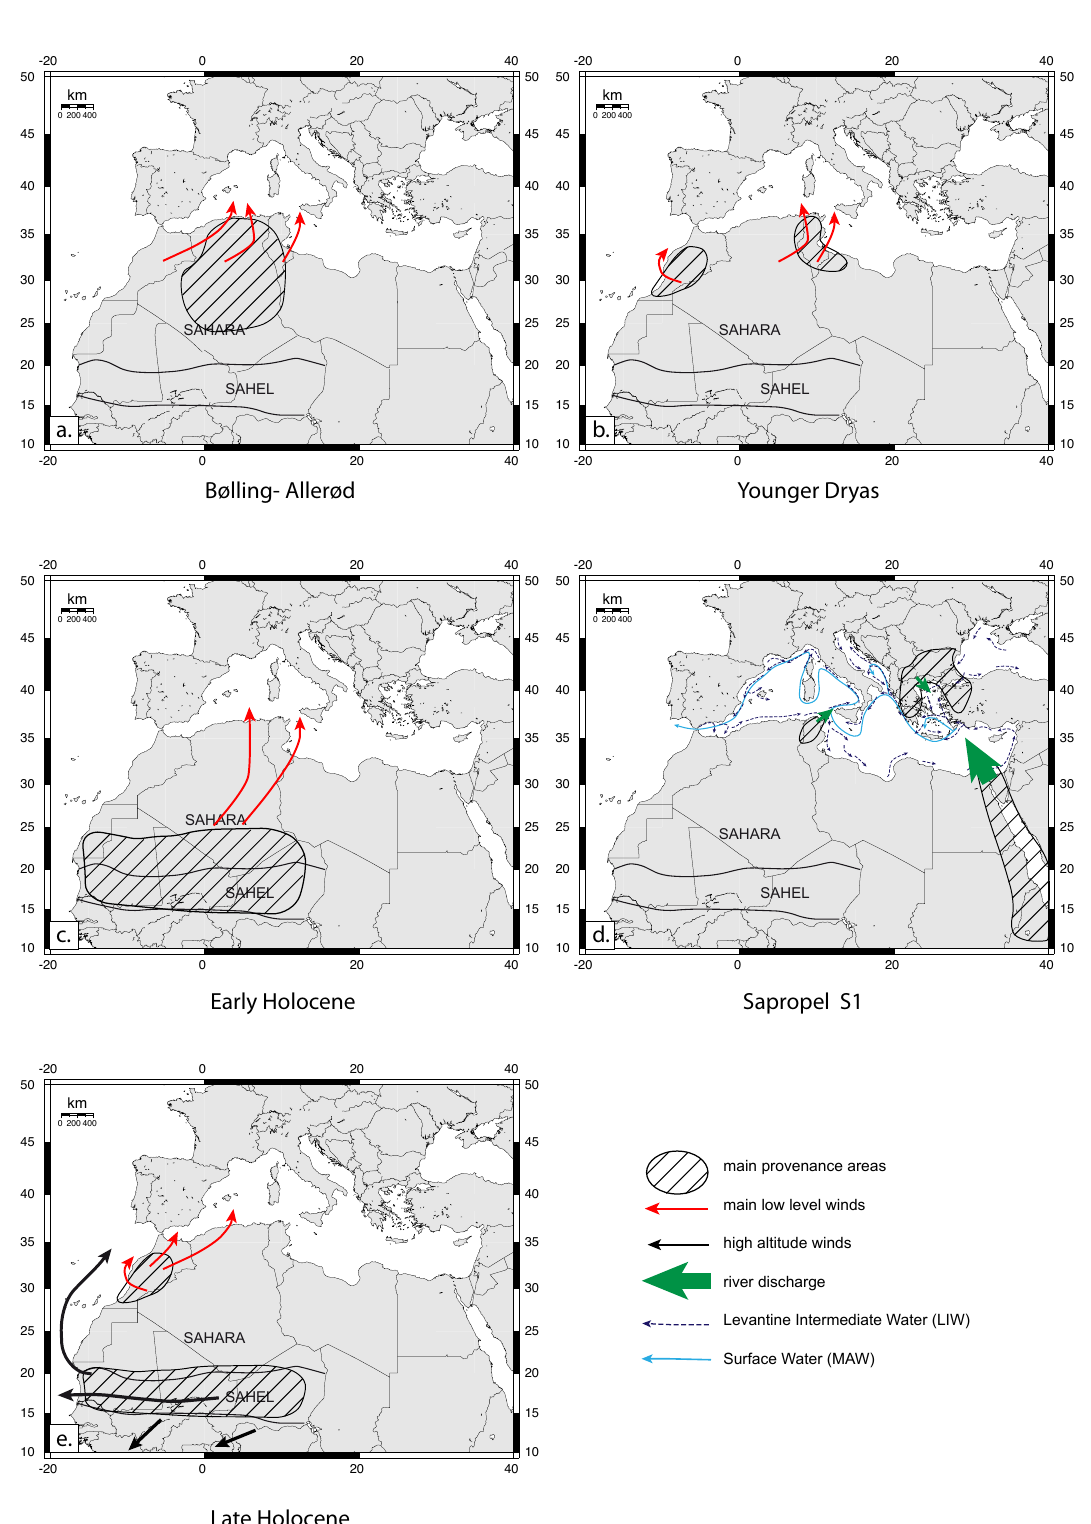
Fig. 7. Main provenance (dashed areas) and potential eolian – low level (red arrows) or altitude winds (black arrows) – and riverine (green arrows) transportation patterns of clay-mineral particles for 5 time slices: (a) Bølling–Allerød; (b) Younger Dryas; (c) early Holocene; (d) Sapropel S1; (e) late